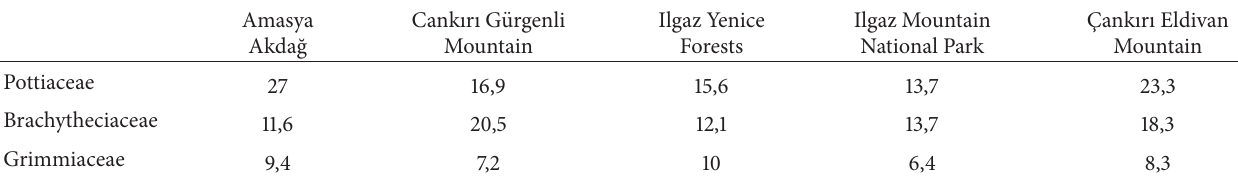
Table 2: The comparison of the taxa distribution according to the families. Amasya